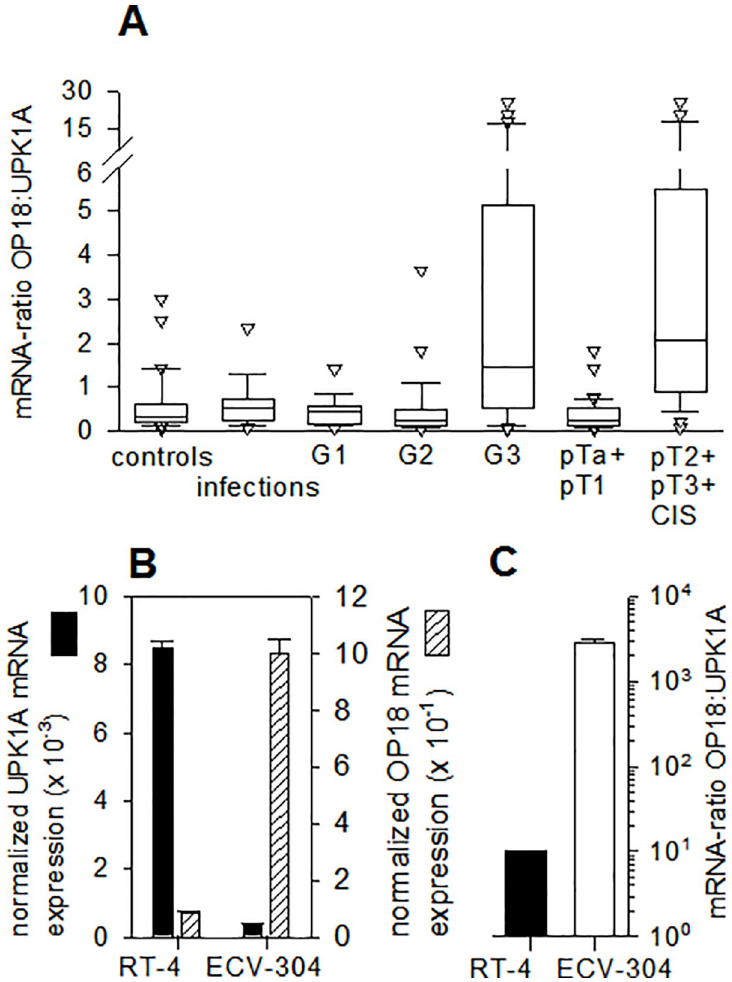
Fig 1. Urinary levels of the mRNA-based tumor marker OP18:UPK1A. (A), Box-Plot of the urinary mRNA ratio OP18:UPK1A. The qRT-PCR-based detection of OP18- and UPK1A mRNA was performed in triplicate. Donors were of different health status, including healthy individuals and individuals suffering from infections of the urinary tract or BCa as stratified according to grade (G1, G2 or G3) and stage, respectively (see Materials and Methods for details). Upper and lower limits of boxes and lines across boxes indicate the 75 th and 25 th percentiles and median, respectively. Error bars indicate the 90 th and 10 th percentiles. White triangles indicate outlying data points. The RNA ratio of OP18: UPK1A is significantly ( p < 0.001) increased in patients with poorly differentiated (G3) BCa as well as invasive BCa ( � pT2). (B), UPK1A- and OP18 mRNA expression in human BCa cell lines. Total RNA was prepared in triplicate from ECV-304 and RT-4 cells in the exponential phase of growth. Absolute mRNA copy numbers of OP18, UPK1A, and RPLP0 (60S acidic ribosomal protein P0), internal reference mRNA) were determined in triplicate by qRT-PCR using standard curves. Columns represent mean values ± standard deviation of UPK1A and OP18 mRNA copies after normalization to RPLP0 mRNA levels. (C), Ratio of OP18:UPK1A mRNA signals in RT-4 and ECV-304 cells. This ratio was calculated from single mRNA expression profiles presented in Fig 1B and shows a significant increase by approximately two orders of magnitude in poorly differentiated ECV-304 cells.